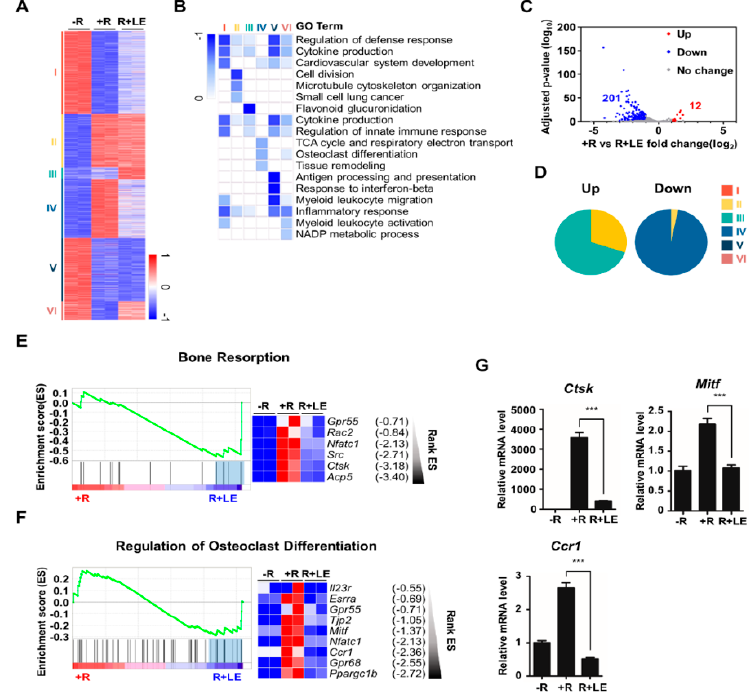
Figure 2. Leaf extract of Abeliophyllum distichum alters gene expression profiling during osteoclastogenesis. ( A ) K-means (K = 6) clustering of 2,573 differentially expressed genes (DEGs) in any pairwise comparison among three conditions. Clusters are indicated on the left (-R; no RANKL, +R; RANKL (100 ng/mL), R + LE; RANKL (100 ng/mL) + LE of A. distichum (10 μ g/mL) for 3 days. ( B ) Heatmap showing the P -value significance of GO term enrichment for genes in each cluster. ( C ) Volcano plot of transcriptomic changes of RANKL-induced genes by LE treatment; colored dots correspond to genes with significant (FDR < 0.05) and greater than two-fold expression changes. ( D ) Pie chart showing each cluster portion of up or down DEGs. Up: Cluster 1 (33.2%), Cluster 2 (1.7%), Cluster 3 (21.3%), Cluster 4 (0%), Cluster 5 (0%), and Cluster 6 (43.8%). Down: Cluster 1 (0%), Cluster 2 (1.7%), Cluster 3 (0%), Cluster 4 (89.8%), Cluster 5 (7.6%), and Cluster 6 (0%). ( E-F ) GSEA analysis plot and heatmap showing decreased gene expression of the Bone Resorption and Regulation of Osteoclast Differentiation in LE compared to +R. ( G ) BMM cells were cultured for 3 days in the presence of M-CSF (30 ng/mL) and RANKL (100 ng/mL) in the absence or the presence of LE. To quantify relative mRNA levels, qRT-PCR was performed using primers specific for Ctsk , Mitf , and Ccr1 . The results shown are mean values from three independent experiments; * p < 0.05, ** p < 0.01, *** p < 0.001. 3.3. Leaf extract of Abeliophyllum distichum Decreases RANKL-Induced NFATc1 Expression RANKL/RANK signals to downstream targets such as c-FOS, NF- κ B, and NFATc1, which are key transcription factors implicated in NFATc1 transactivation during osteoclastogenesis [12]. To examine the influence of LE of A. distichum on mRNA expression of Nfatc1 , c-Fos , and p65 , we first checked the reads per kilobase per million of those mRNA from RNA-seq data. As shown in Figure 3A, LE blocked Nfatc1 expression induced by RANKL, but LE had less of an effect on c-Fos and p65 expression. We further confirmed the selective inhibitory effect of LE on Nfatc1 expression by qRT- PCR analysis (Figure 3B). Consistent with qRT-PCR results, LE significantly reduced the expression of RANKL-induced NFATc1 expression, as shown in Figure 3C.